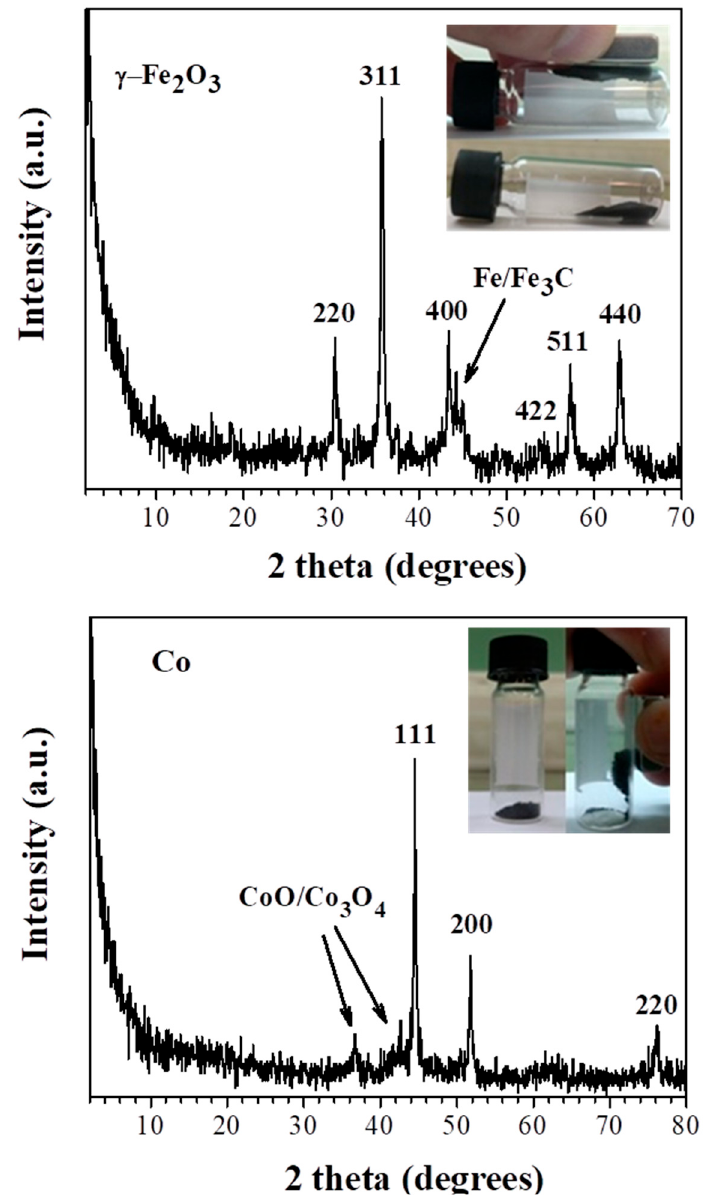
Figure 8. XRD patterns of (top) the as-derived γ -Fe 2 O 3 and (bottom) Co magnetic powders. The insets show the strong attraction of the magnetic solids by Nd-magnet.